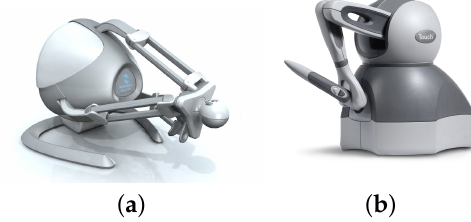
Figure 1. Commercial haptic devices: ( a ) Novint Falcon haptic device and ( b ) Geomagic Touch, (previously SensAble Phantom